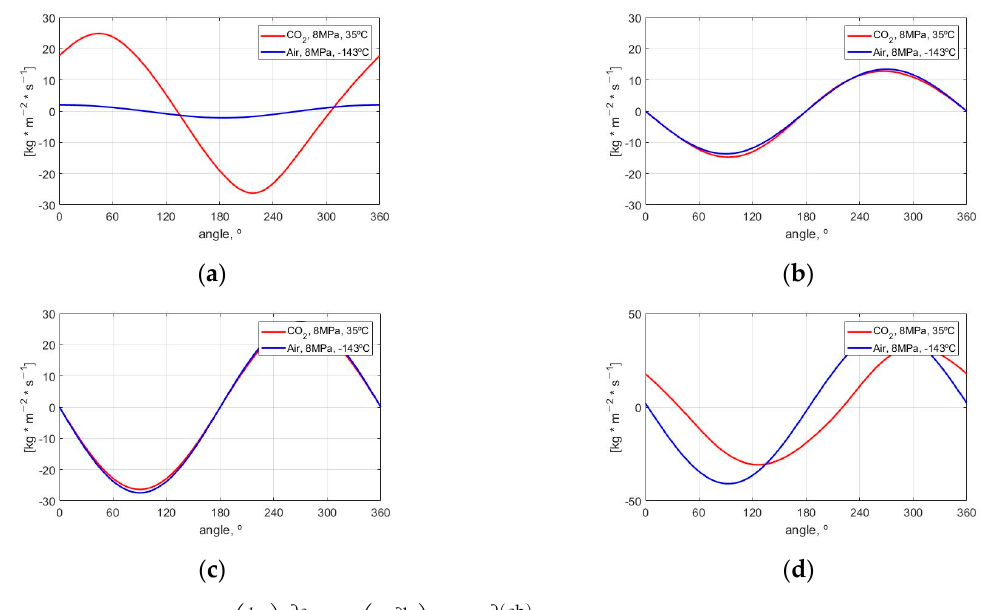
Figure 9. The distributions of ( a ) (cid:4672) (cid:3035)(cid:3048) around the shaft with ε = 0.25 and 30,000 rpm.